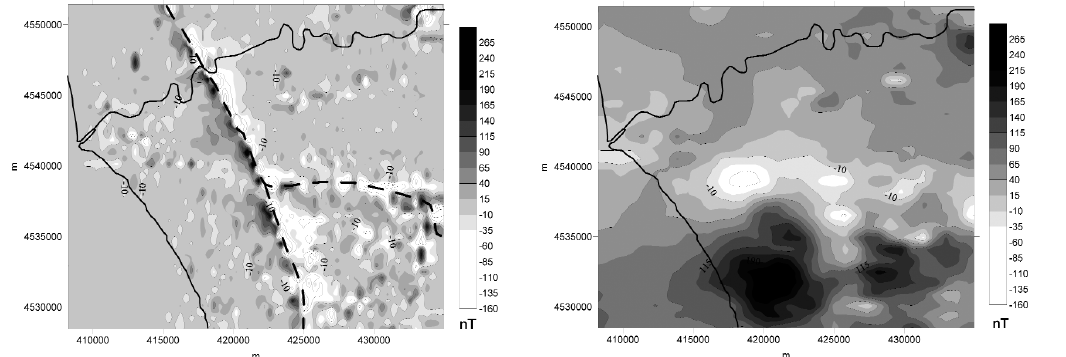
Fig. 5. Aeromagnetic field at 70 m above the ground surface after the filtering and denosing